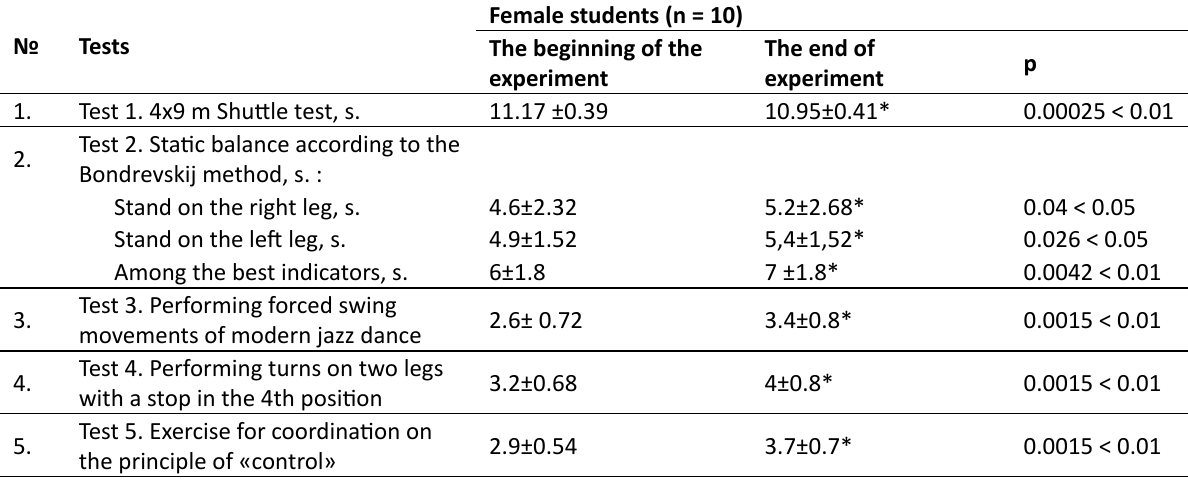
Table 2. Dynamics of coordination readiness indicators of female